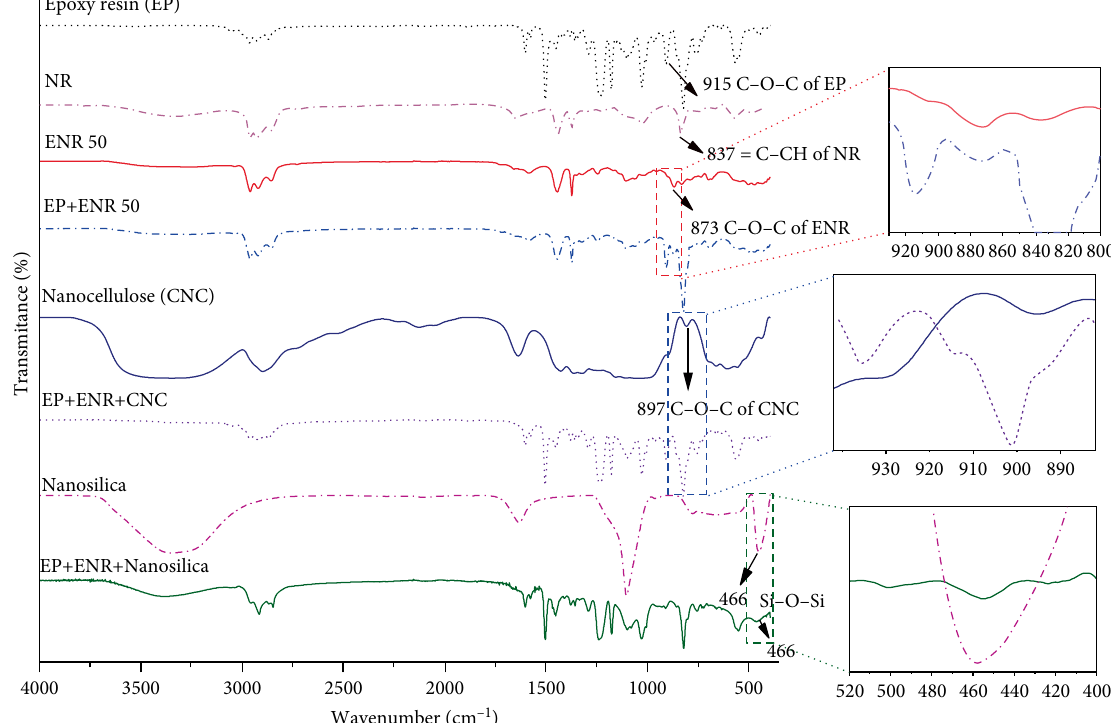
Figure 3: The FTIR spectra of various types of composites materials.